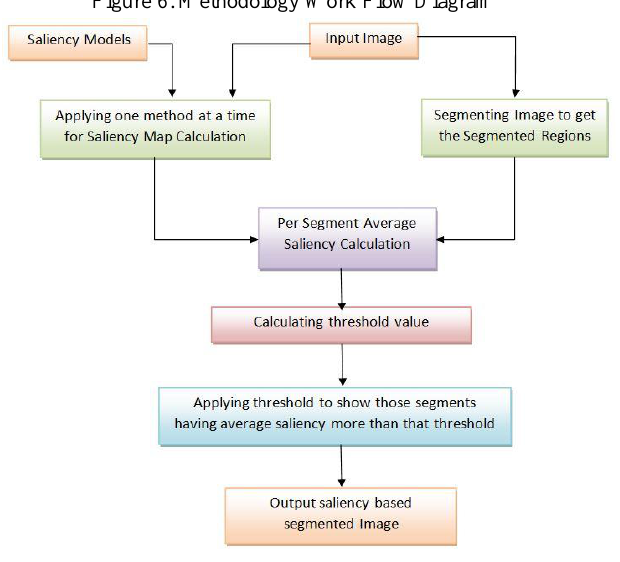
Figure 6. Methodology Work Flow